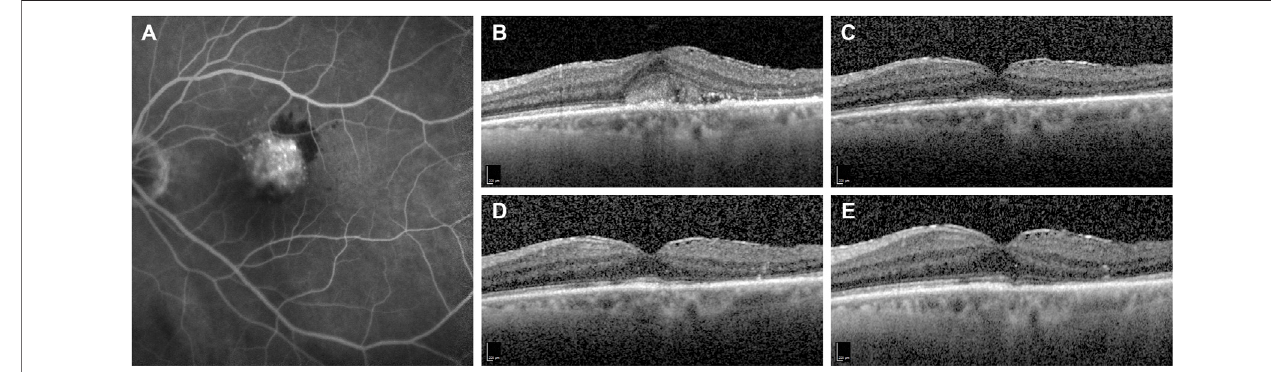
FIGURE 1 | Representative case of a naïve patient presenting with choroidal neovascularization secondary to neovascular age-related macular degeneration treated with monthly intravitreal brolucizumab (IVT-B). (A) Baseline fl uorescein angiography demonstrates the presence of a subfoveal type 2 choroidal neovascularization with adjacent subretinal hemorrhage. (B) Optical coherence tomography (OCT) B-scan at baseline reveals the presence of mild subretinal fl uid (SRF) and subretinal hyperre fl ective material (SHRM) in the foveal area. An epiretinal membrane is also visible. (C) OCT B-scan 1 month after the fi rst IVT-B shows the resolution of the SRF and the SHRM with reduction of the central sub fi eld thickness from 375 to 295 µm. (D) OCT B-scans at 2-month and (E) at 3-month visit demonstrate the absence of recurrences and a dry macula after the loading dose. Best-corrected visual acuity improved from 20/100 to 20/50.